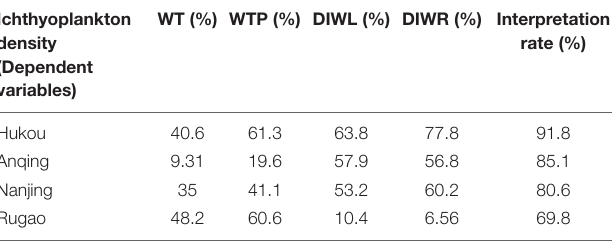
TABLE 4 | Deviation interpretation rate of environmental factors for generalized additive model (GAM) model. Ichthyoplankton density (Dependent